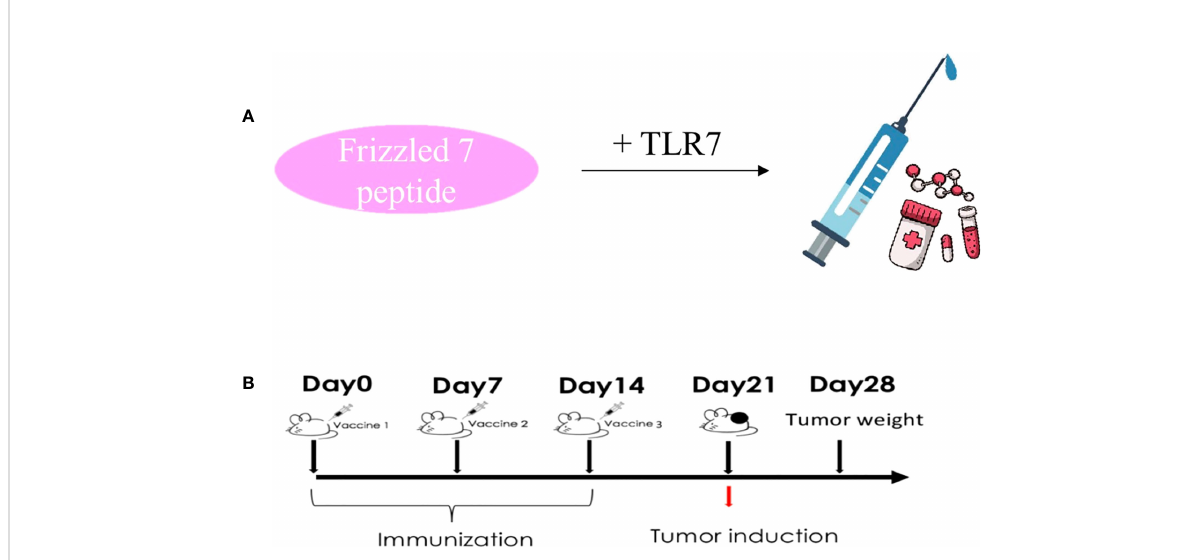
FIGURE 2 Protocol design route. (A) Vaccine preparation process diagram. (B) Immunological administration and tumorigenesis schedule.